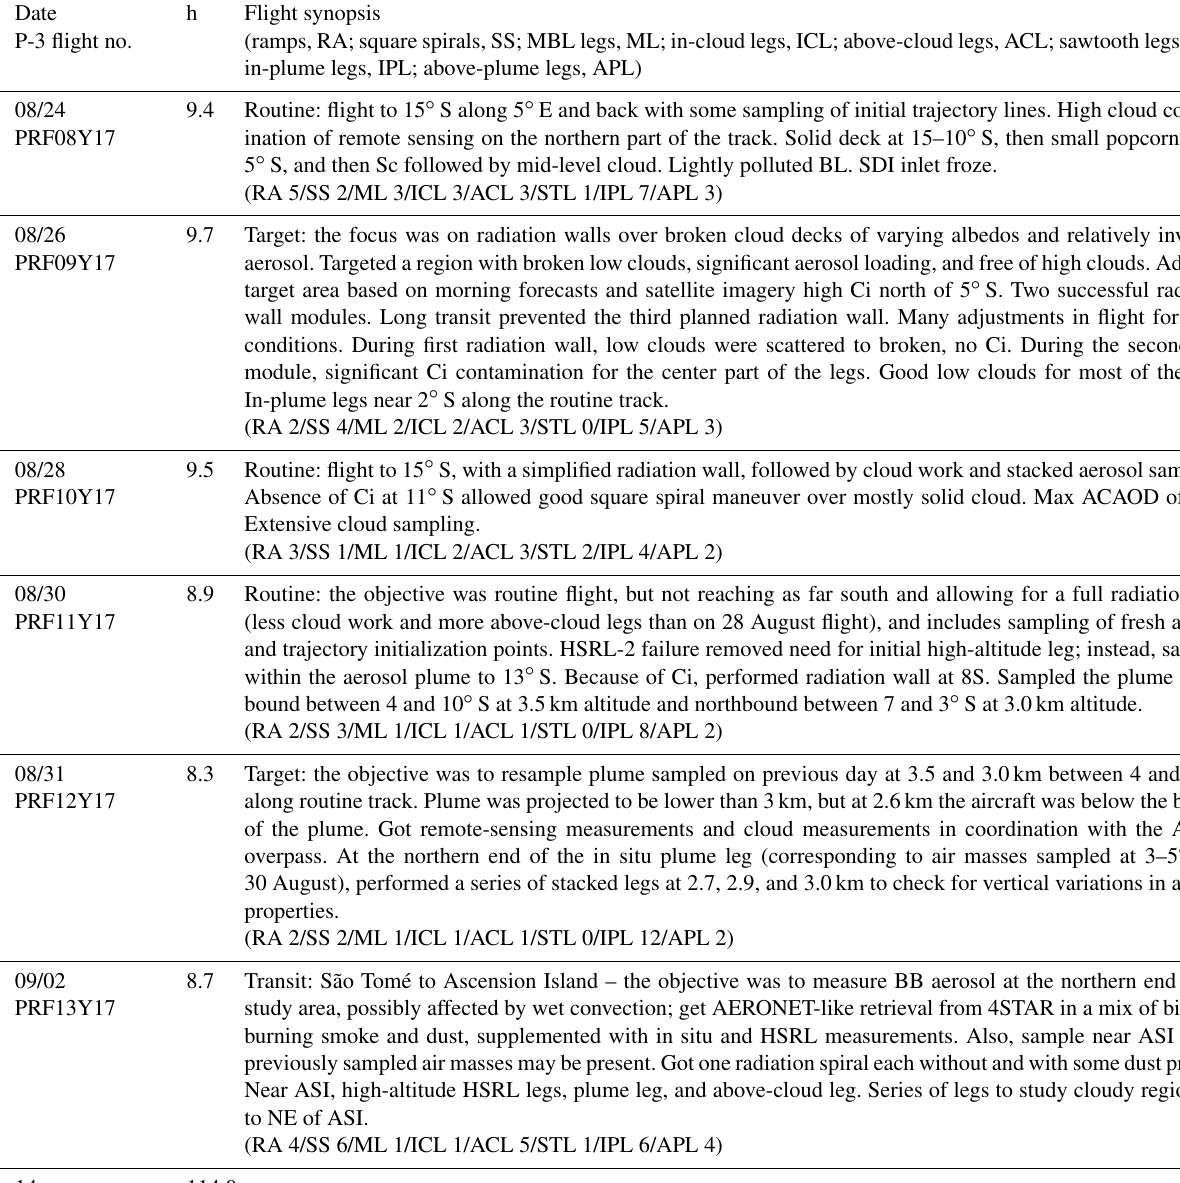
Routine: flight to 15 ◦ S along 5 ◦ E and back with some sampling of initial trajectory lines. High cloud contam- ination of remote sensing on the northern part of the track. Solid deck at 15–10 ◦ S, then small popcorn Cu to